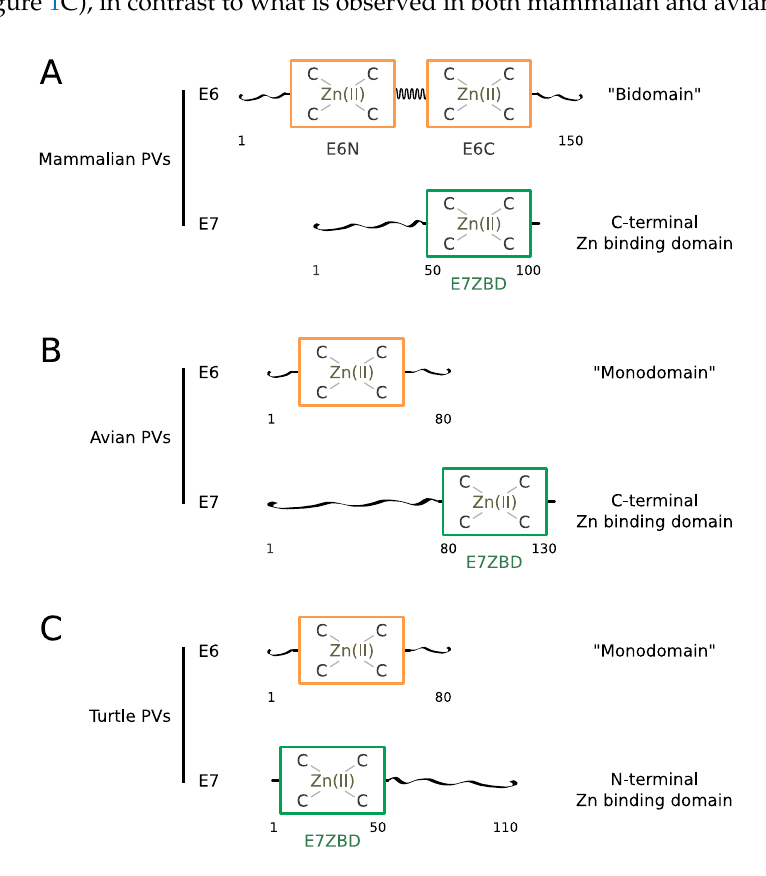
Figure 1. Schematics of E6 and E7 sequences across distinct vertebrates: ( A ) mammals; ( B ) birds; ( C ) turtles. Folded zinc-binding domains and unfolded regions are represented as rectangles and extended strings, respectively. Approximate amino-acid numbering is indicated below the schemes.